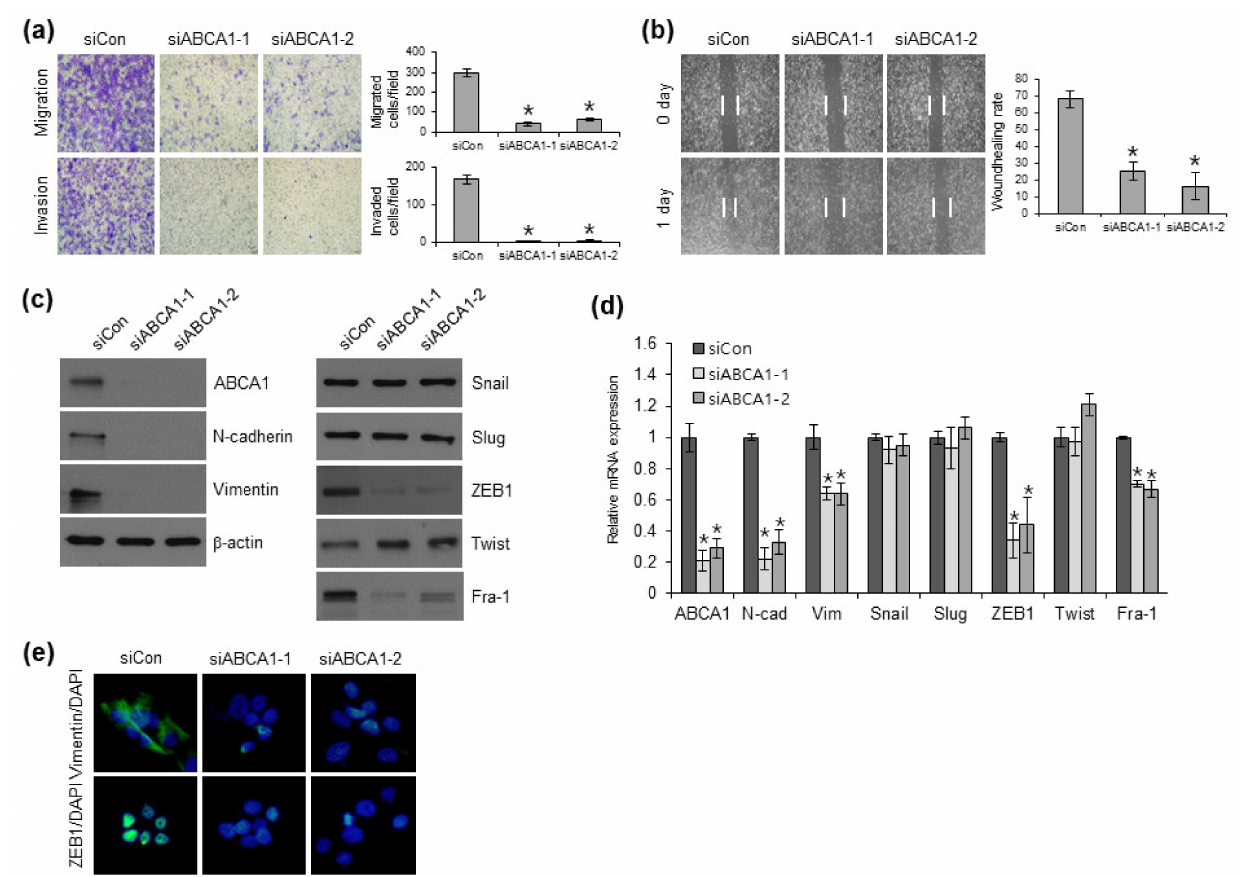
Figure 3. siRNA-mediated ABCA1 knockdown inhibits migration and invasion by targeting epithelial–mesenchymal transition transcription factors (EMT-TF). ( a ) Analysis of migration (upper) and invasion (lower) in ABCA1-knocked-down BCPAP cells. * p < 0.05 versus siCon (Student’s t -test). ( b ) Wound-healing capacity after ABCA1 knockdown was examined in BCPAP cells. After 24 h, five different wounds in the picture were randomly selected and measured for quantification. ( c – e ) Expression levels of the indicated EMT-related proteins in siRNA-mediated ABCA1-knocked-down BCPAP cells were analyzed via Western blotting, qRT-PCR, and immunocytochemistry. DAPI was used to stain the nuclei of cells. The data in ( a , d ) represent the means ± S.D. of triplicate